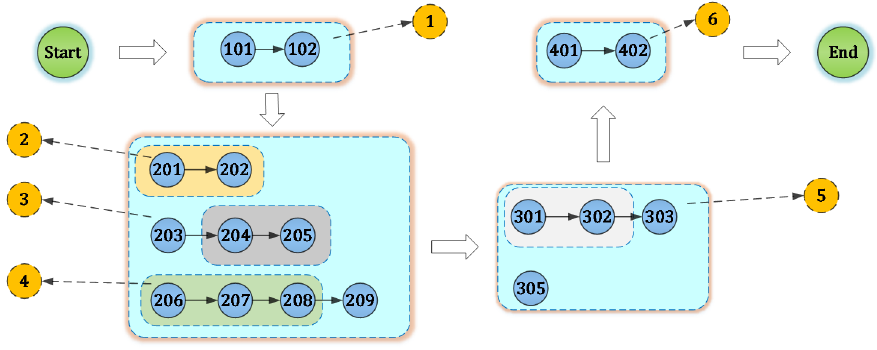
Figure 5. Manufacturing process model with six manufacturing process units (MPUs).